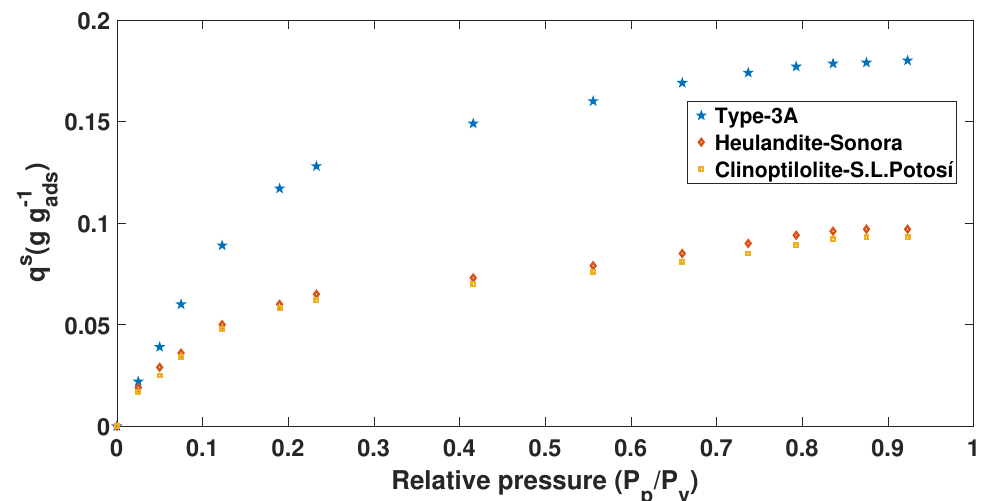
Figure 4. The 70 ◦ C Adsorption isotherm ( H 2 O / C 2 H 5 OH mixture) of Brunauer–Emmett–Teller (BET).